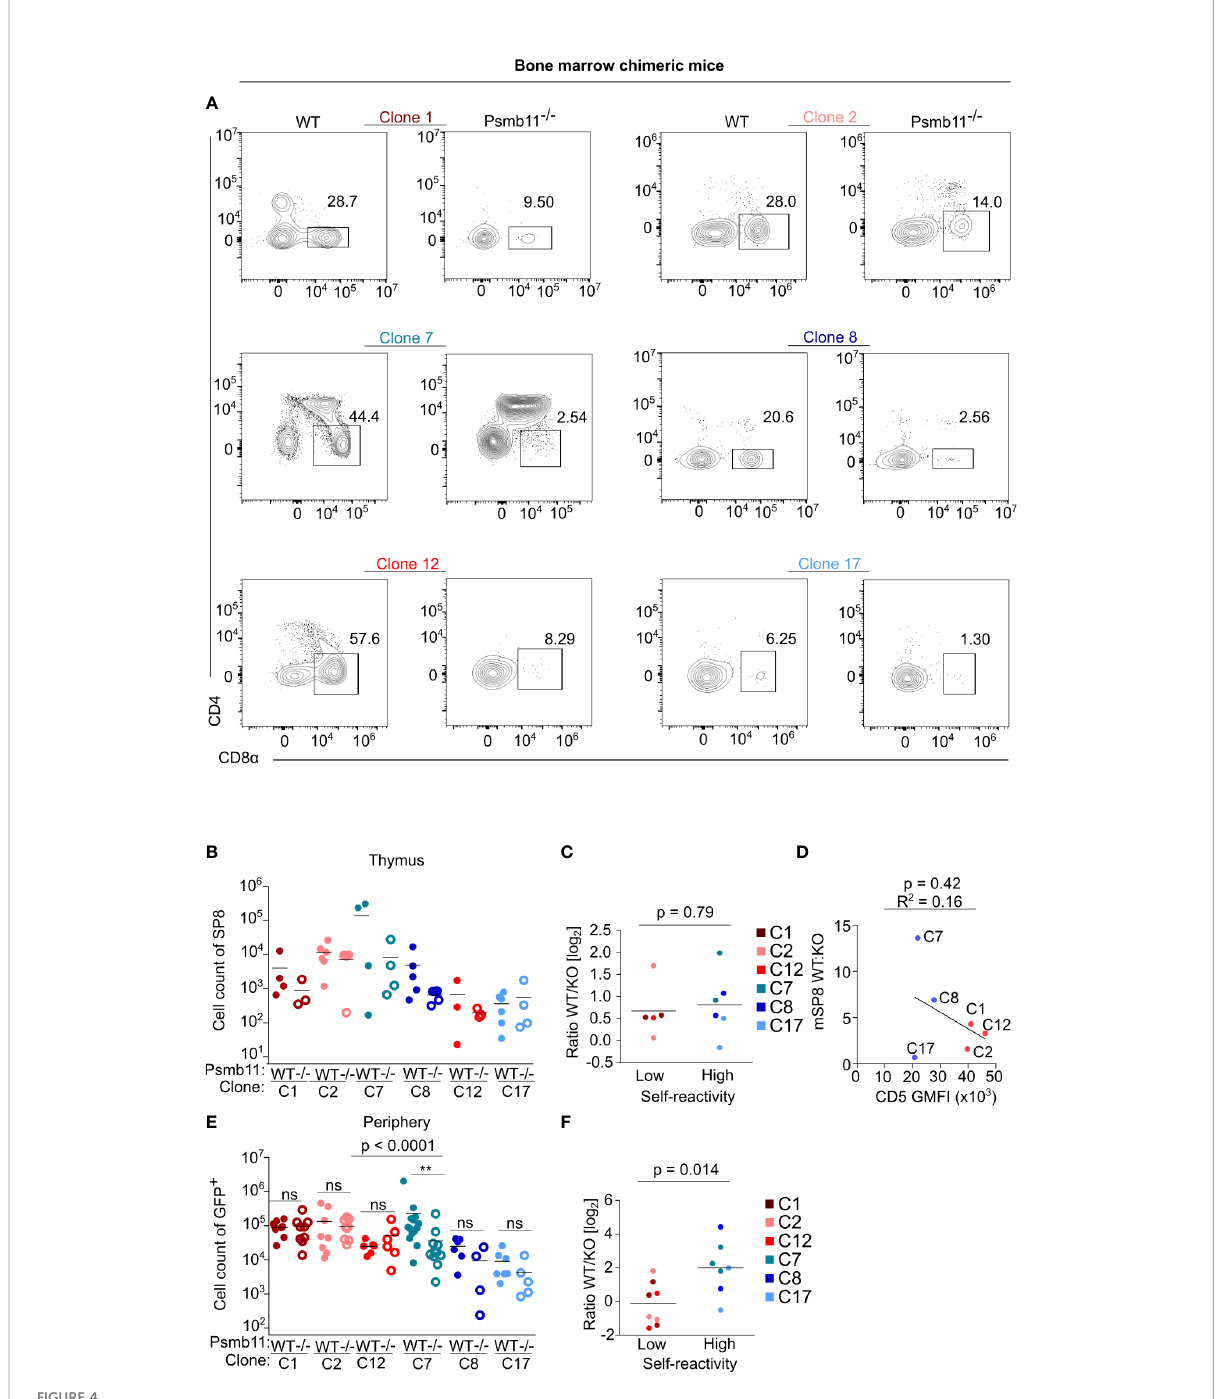
FIGURE 4 Generation of bone marrow chimeras of the clones in thymoproteasome de fi cient mice. WT or Psmb11 -/- mice were sub-lethally irradiated and transplanted with hematopoietic stem cells transgenic for the indicated clones. Eight weeks later, thymi and LNs were analyzed by fl ow cytometry. n = 4-8 mice per group from three independent experiments. (A) Representative FACS plots showing thymic mature SP8 for all of the clones in WT or Psmb11 -/- mice. (B) Numbers of donor mature SP8 in thymi of WT or Psmb11 -/- mice. Mean. n = 4-5 mice per group from two independent experiments. (C) Numbers of donor CD8 + T cells isolated from thymi of WT or Psmb11 -/- mice depicted as a ratio between WT and Psmb11 -/- (KO). Median. The statistical analysis was performed using the two-tailed Mann Whitney U test. (D) A linear fi t between the WT : KO ratio of mature SP8 cells and CD5 gMFI levels. (E) Numbers of donor CD8 + T cells isolated from LNs of WT or Psmb11 -/- mice. n=4-8 mice per group from three independent experiments. The statistical analysis was performed using Kruskal – Wallis test with Dunn ’ s post-tests. (F) Numbers of donor CD8 + T cells isolated from LNs of WT or Psmb11 -/- mice depicted as a ratio between WT and Psmb11 -/- (KO). Median. The statistical analysis was performed using the two-tailed Mann Whitney U test. ** p<0.01, ns (not signi fi cant)